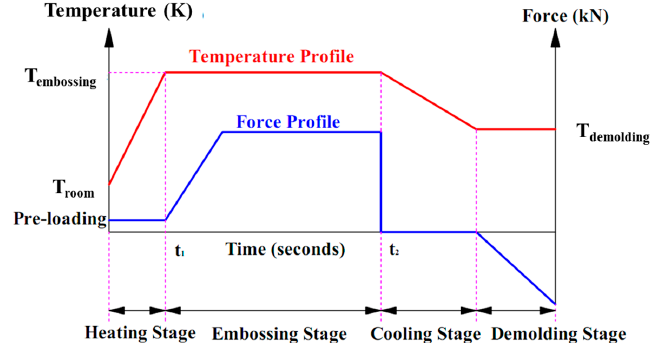
Figure 3. Profile measurements of micro-array channels dies with different widths: ( a ) 50 μ m;